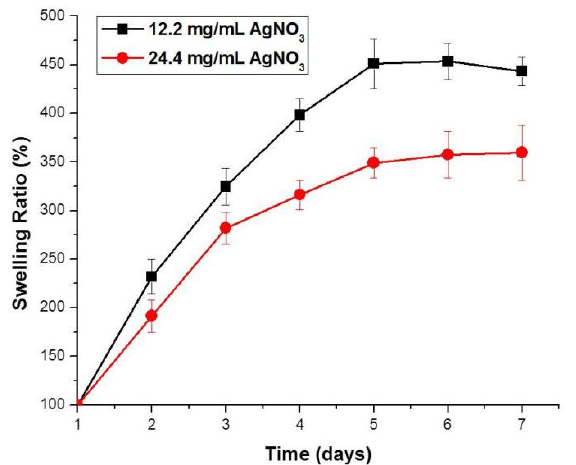
Figure 4. Time-dependent swelling ratios of DA-GLT 1 /AgNPs hydrogels with different feeding concentrations of AgNO 3 .